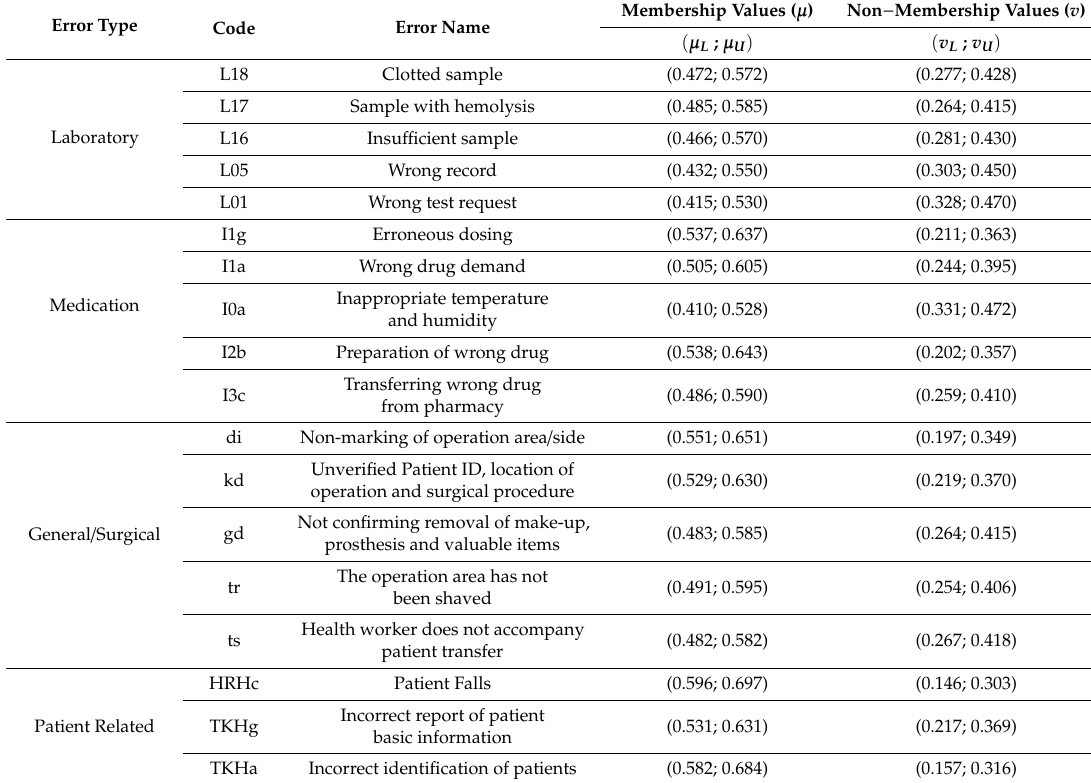
Table 7. Final Aggregated Scores for Errors, in Terms of Severity